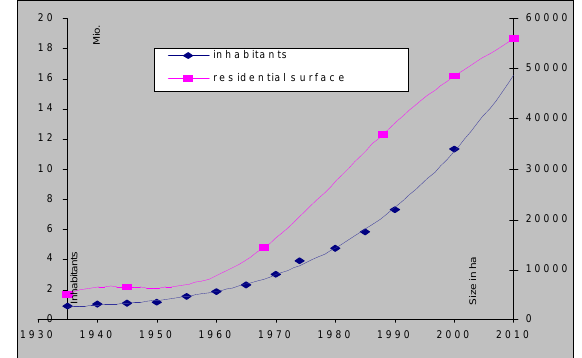
Figure 4: Growth of population and residential surface.